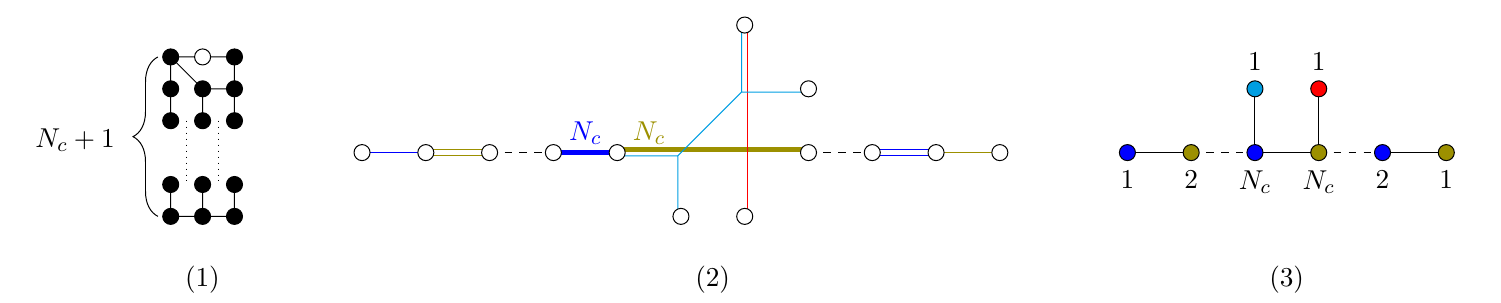
Figure 18 . (1) Toric Diagram representing SQCD with N f = 2 N c + 1 at finite gauge coupling where masses are set to zero. This is an abuse of notation since the diagram corresponds to a non-toric geometry; the white dots stand for shrunken faces following [17]. This comment also applies to figure 19. (2) Brane Web indicating the Higgs Branch (3) magnetic Quiver whose 3d Coulomb Branch is the Higgs Branch of our SQCD.